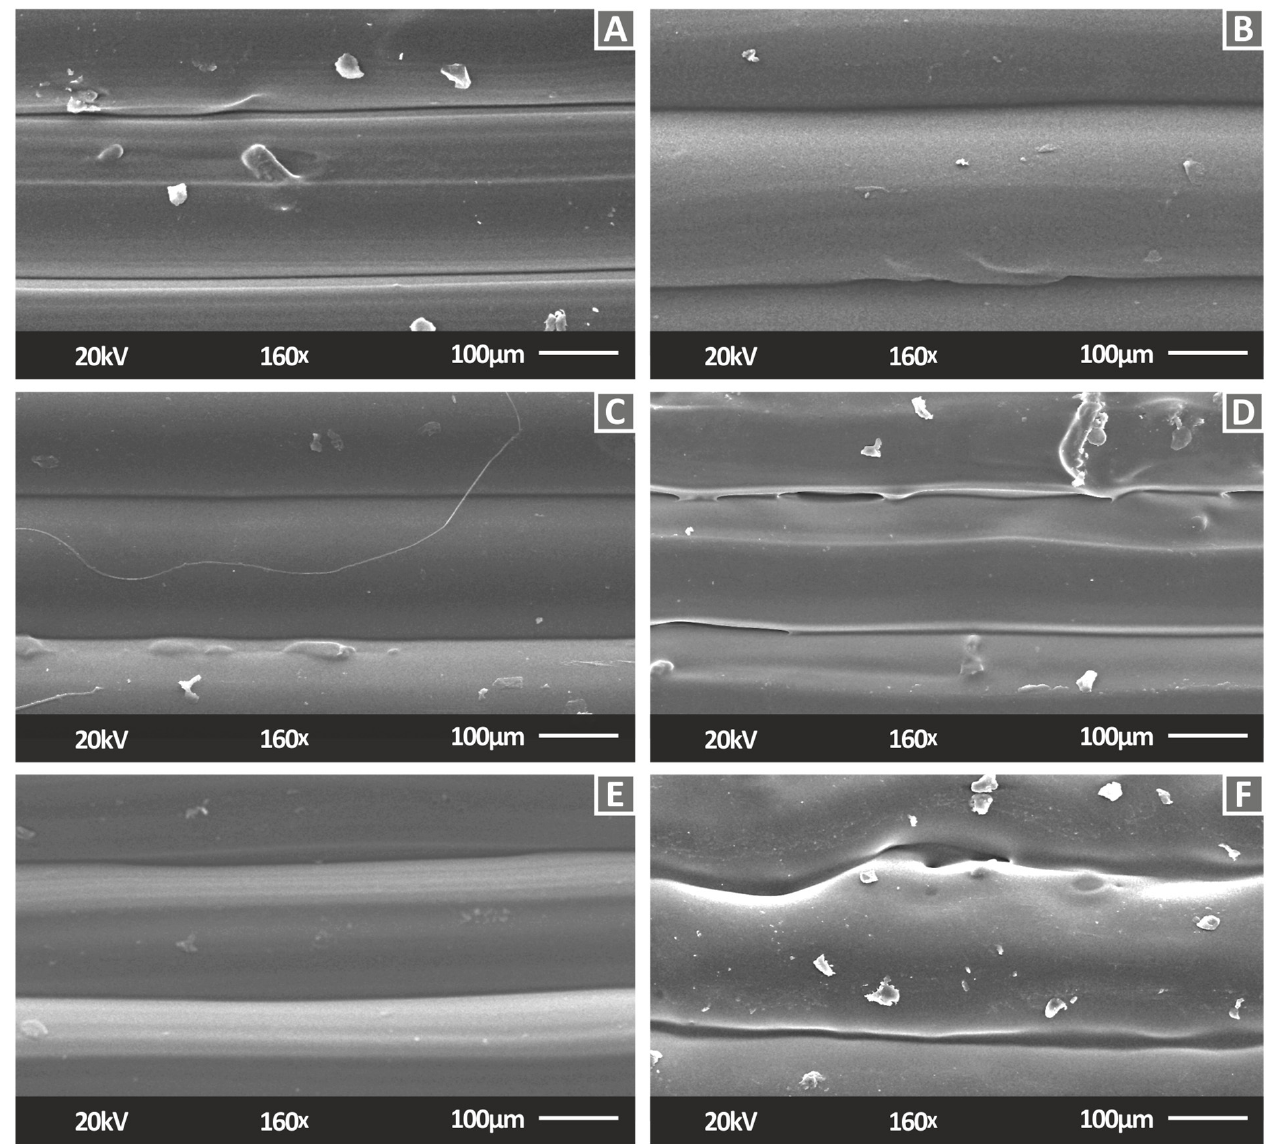
Figure 12. SEM images at 160× magnification for the side surface of the 3D-printed tensile specimens made with the nanocomposites tested in this work, PLA with: ( A ) 0.5 wt.% CNF, ( B ) 0.5 wt.% Cu 2 O,